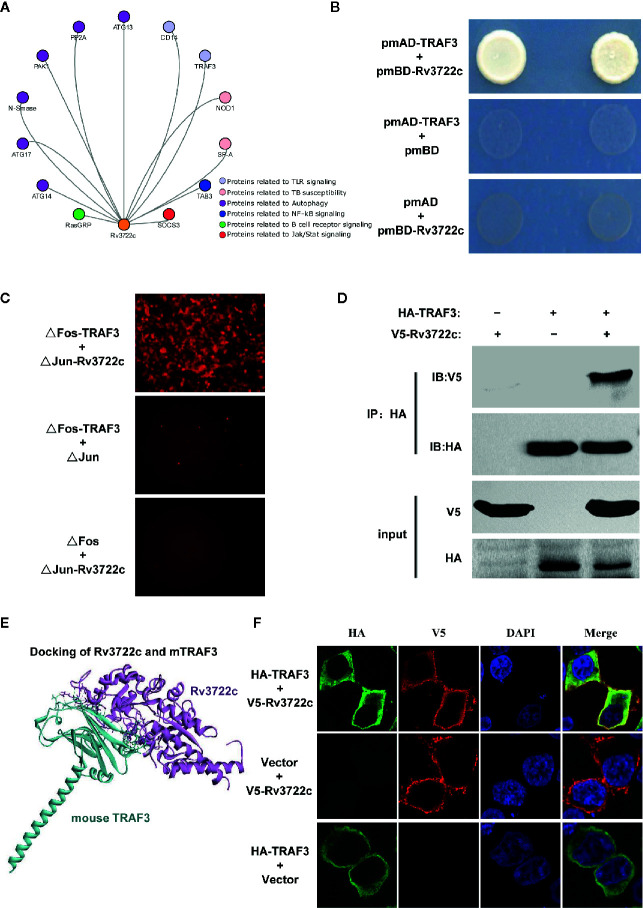
Rv3722c interacts with TRAF3. (A) Delineation of the filtered PPI sub-network between Rv3722c and host proteins. The orange node represented Rv3722c and other colors represented host different immune pathway proteins. (B) Verification of the protein-protein interaction by Y2H assay. Rv3722c in the pmBD destination vector was used as bait. TRAF3 in the pmAD destination vector was used as prey. Co-transformation of pmBD empty vector with pmAD vector containing TRAF3 and co-transformation of the pmAD empty vector with pmBD vector containing Rv3722c were used as negative controls. Yeast cells grown on SD/Leu−Trp−His−Ade− selective plates indicated the interaction between Rv3722c and TRAF3. (C) Verification of the protein-protein interaction by BiFC assay. ΔJun-Rv3722c was co-transfected with ΔFos-TRAF3 and the negative controls into HEK 293T cells, respectively. Cells were harvested 36 h after transfection for fluorescence microscopy-based image analysis. The interaction between Rv3722c and TRAF3 allowed the re-formation of a bimolecular fluorescent complex. (D) Verification of the protein-protein interaction by Co-IP assay. V5-tagged Rv3722c and HA-tagged TRAF3 were co-transfected into HEK 293T cells. Cells were harvested 36 h after transfection for Co-IP assay. Co-transfection of V5-tagged Rv3722c with HA-tagged empty vector and HA-tagged TRAF3 with V5-tagged empty vector were used as negative controls. (E) Protein-protein docking simulated the interaction of Rv3722c and TRAF3. The purple structure represented Rv3722c and the blue-green structure represented TRAF3. (F) Verification of the protein-protein co-localized by immunofluorescence confocal microscopy assay. V5-tagged Rv3722c and HA-tagged TRAF3 were co-transfected into HEK 293T cells. Cells were harvested at 36 h after transfection for immunofluorescence confocal microscopy assay. Co-transfection of V5-tagged Rv3722c with HA-tagged empty vector and HA-tagged TRAF3 with V5-tagged empty vector were used as negative controls. V5-tagged Rv3722c and HA-tagged TRAF3 signals were co-localized in the cytoplasm of HEK 293T cells. All experiments were performed in triplicate.